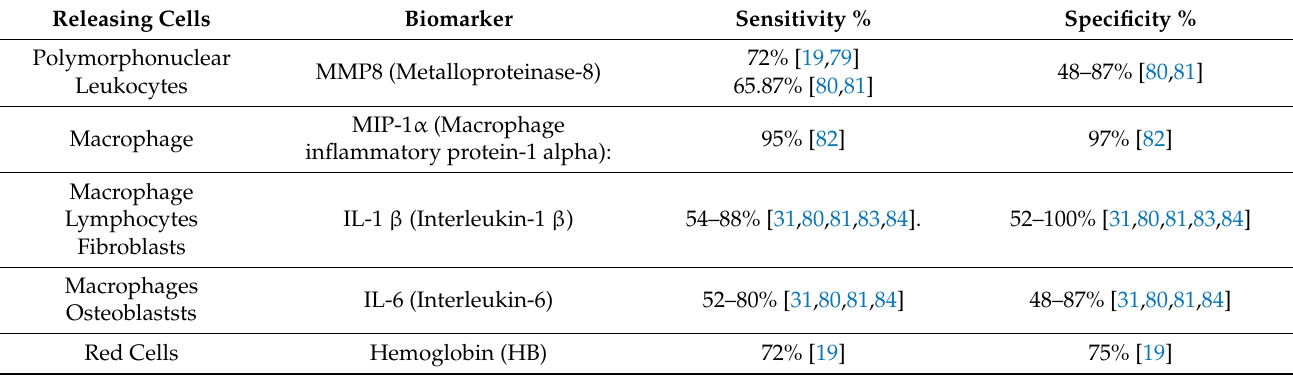
Table 1. Early diagnosis of periodontitis: Sensitivity and Specificity of the most promising host derived biomarkers. Releasing